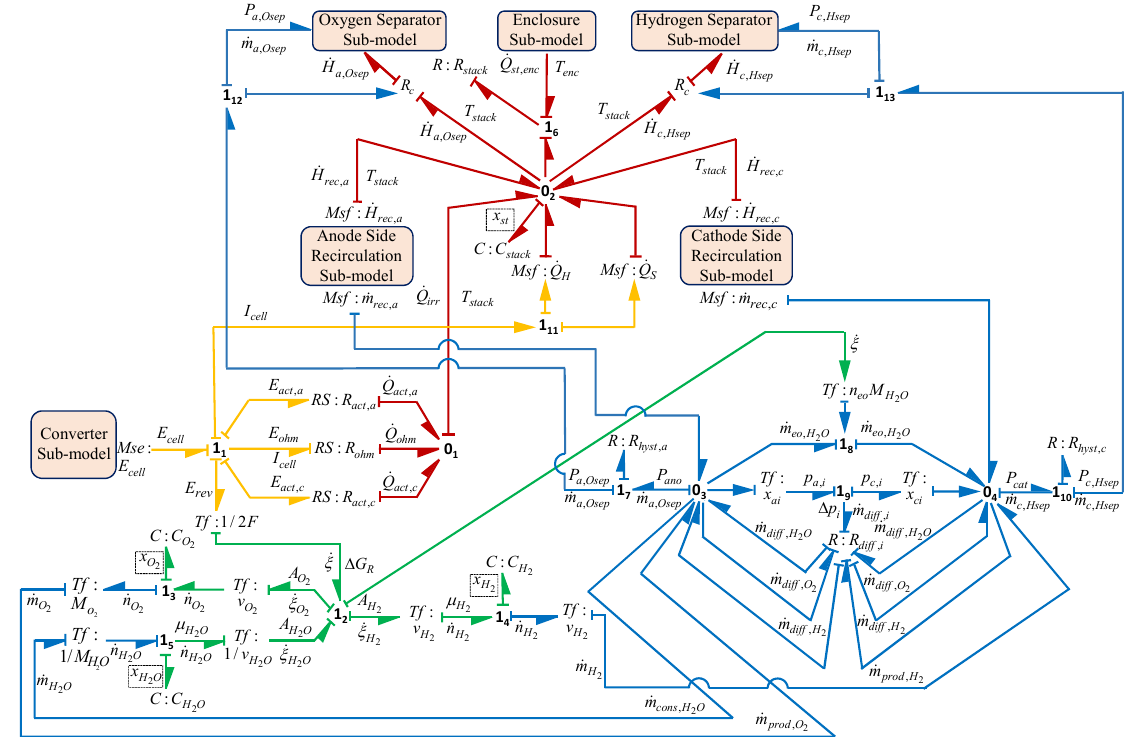
Figure 13. The global model of the stack of the PEM electrolysis